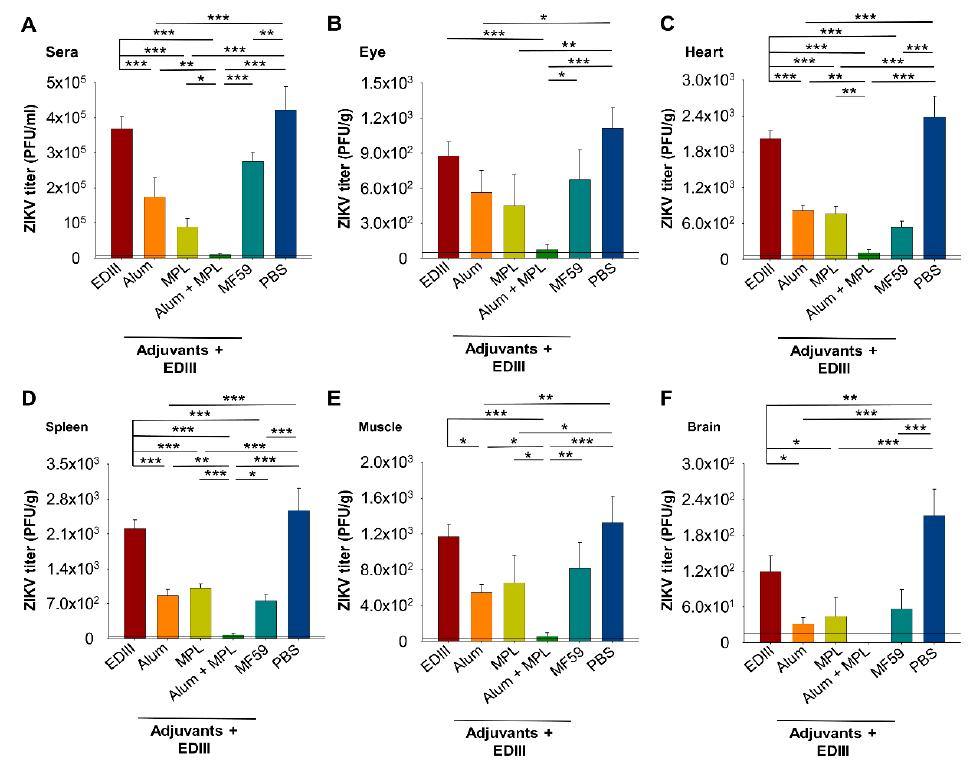
Figure 5. Detection of ZIKV titers in challenged sera ( A ), eye ( B ), heart ( C ), spleen ( D ), muscle ( E ), and brain ( F ). Sera and tissues were collected at three days post-challenge with ZIKV (strain R103451), and viral load determined by a plaque-forming assay. Mice immunized with PBS served as the control. The detection limits for the samples were ~20 PFU/mL (sera), ~50 PFU/g (eye), and ~25 PFU/g (heart, spleen, muscle, and brain). Data are expressed as the mean ± s.e.m ( n = 5). Significant differences (*: p < 0.05; **: p < 0.01; ***: p < 0.001) among different groups are shown.